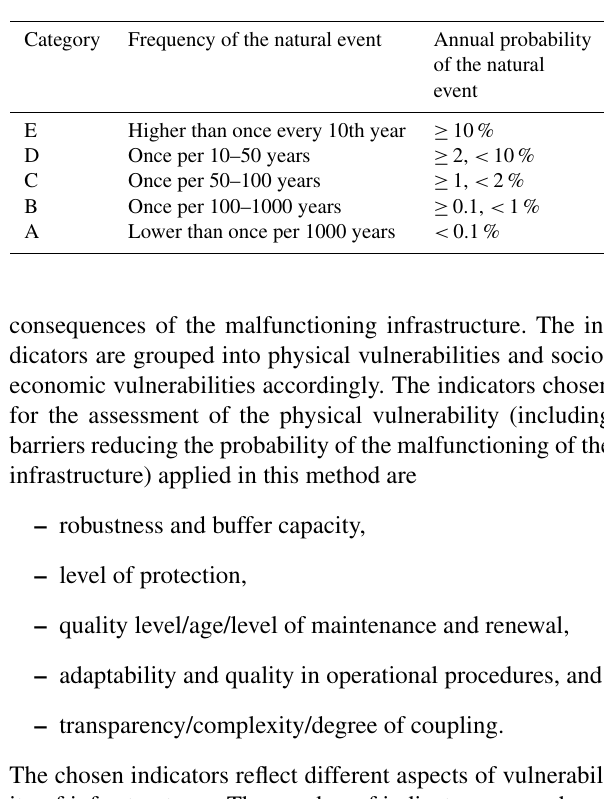
Table 2. Categorisation of the probability: application of the annual probability of the natural event as an initial categorisation of the top event, simplified from the guidelines from the Norwegian Direc- torate for Civil Protection (DSB, 2014). Each category is described both with the frequency and the annual probability of the natural